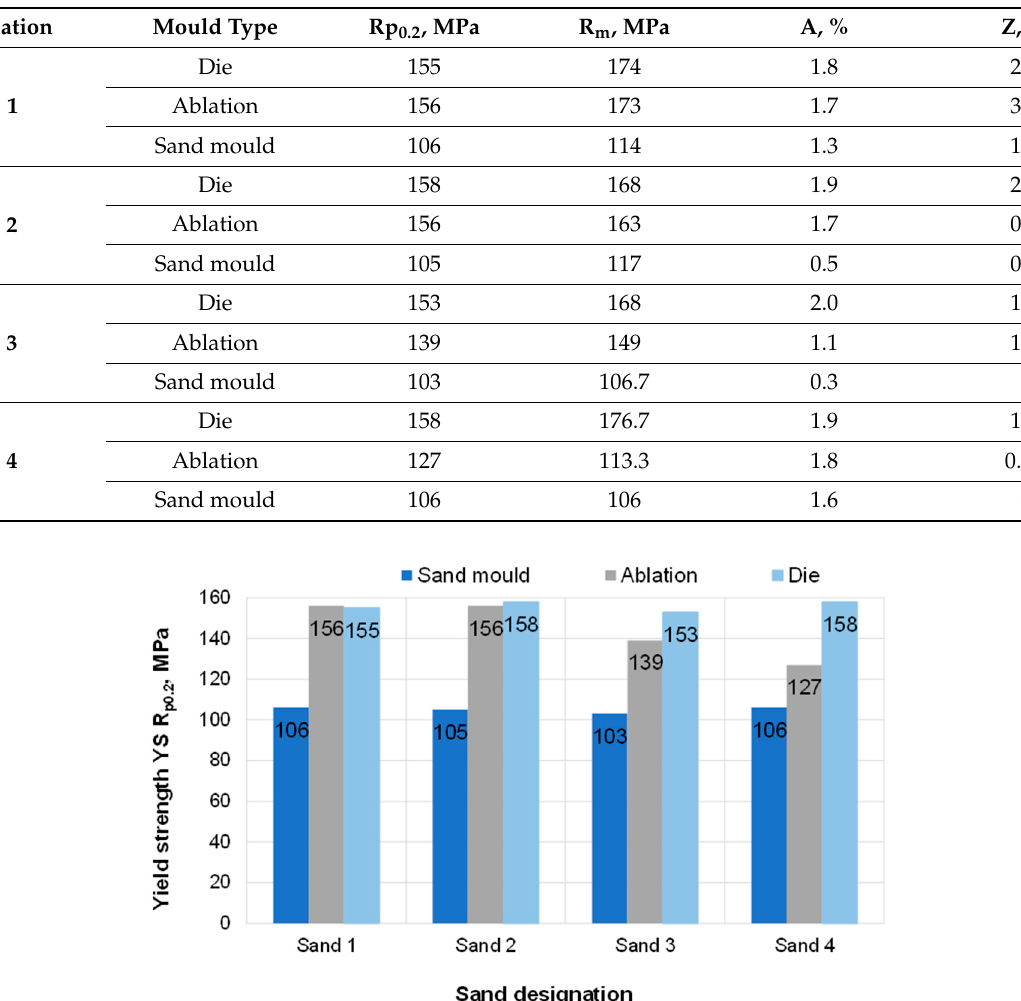
Table 3. Tensile test results obtained for specimens taken from the examined castings (average of 3 measurements).